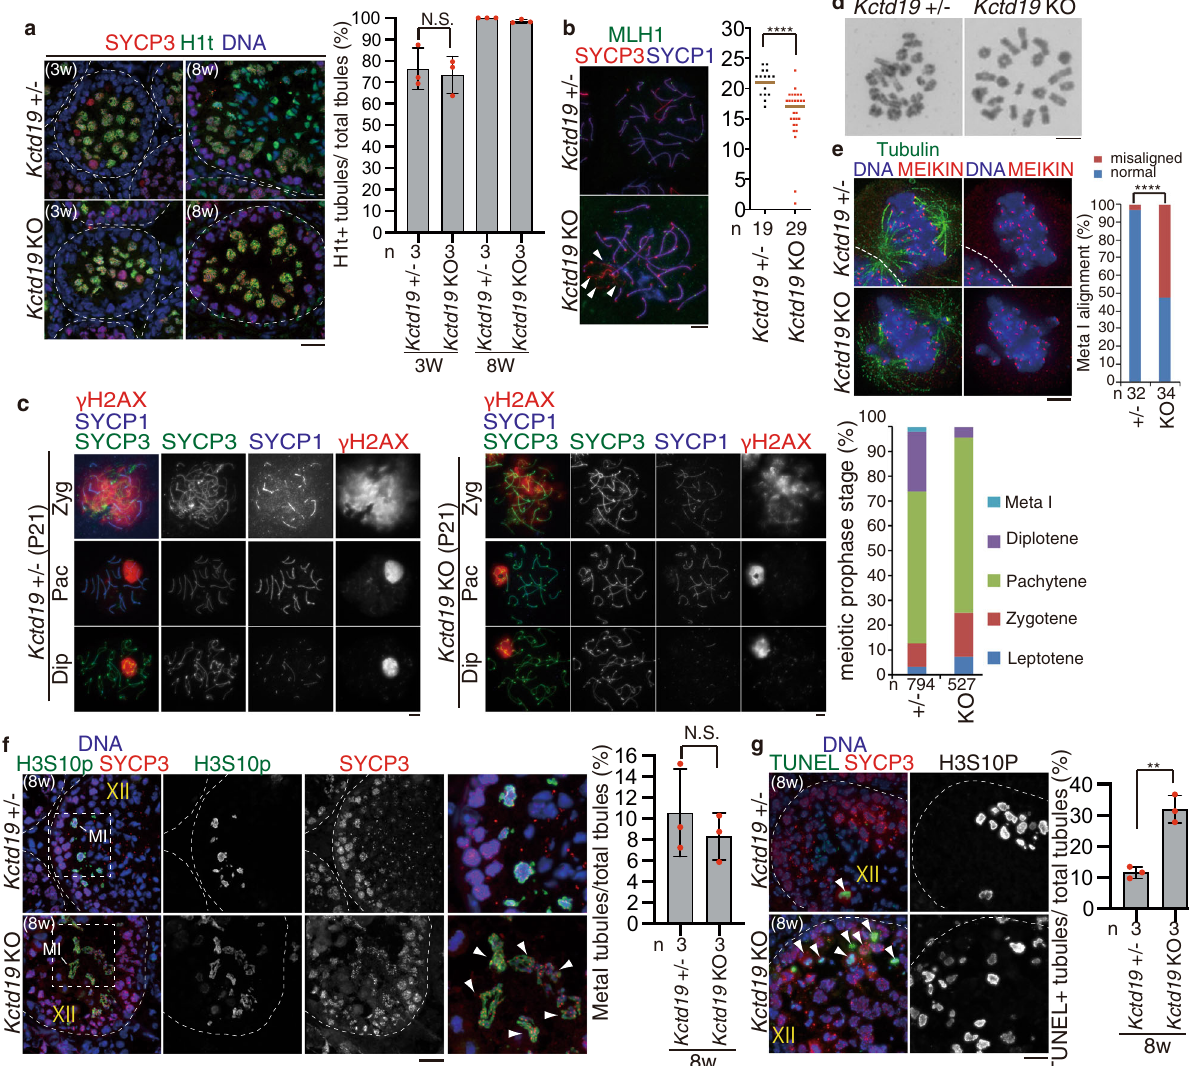
Fig. 6 Kctd19 knockout spermatocytes fail to complete meiosis I. a Seminiferous tubule sections (3-weeks and 8-weeks old) were immunostained as indicated. Shown on the right is the quanti fi cation of the seminiferous tubules that have H1t + /SYCP3 + cells per the seminiferous tubules that have SYCP3 + spermatocyte cells in Kctd19 ± and Kctd19 KO mice (mean with SD). n : the number of animals examined for each genotype. Statistical signi fi cance is shown (two-tailed t -test). N.S.: statistically not signi fi cant. Scale bar: 25 μ m. b Chromosome spreads of Kctd19 ± and Kctd19 KO spermatocytes were immunostained as indicated. The number of MLH1 foci is shown in the scatter plot with median (right). Statistical signi fi cance is shown by p -value (two-tailed Mann – Whitney U -test). **** p < 0.0001. n : number of spermatocytes examined. Asynapsed chromosomes in MLH1 + pachytene spermatocytes are indicated by white arrowheads. Scale bar: 5 μ m. c Chromosome spreads of Kctd19 ± and Kctd19 KO spermatocytes at P21 were immunostained as indicated. Zyg: zygotene, Pac: pachytene, Dip: diplotene. Quanti fi cation of meiotic prophase stage per total SYCP3 + spermatocytes of Kctd19 ± and Kctd19 KO mice is shown on the right. n : the number of cells examined. Scale bar: 5 μ m. d Giemza staining of metaphase I chromosomes from Kctd19 ± and Kctd19 KO spermatocytes. Independent Metaphase I cells (at least N = 19) for each genotype were examined in a single experiment. Scale bar: 5 μ m. e Immunostaining of squashed metaphase I spermatocytes from Kctd19 ± and Kctd19 KO. The metaphase I kinetochores were identi fi ed by MEIKIN immunostaining. Quanti fi cation of metaphase I spermatocytes with chromosome misalignment is shown on the right. n : the number of spermatocytes examined. Statistical signi fi cance is shown by **** p = 2.65 × 10 − 10 (chi-square test). Scale bar: 5 μ m. f Seminiferous tubule sections (8-weeks old) were stained for SYCP3, H3S10p, and DAPI. M I: Metaphase I spermatocyte. Enlarged images are shown on the rightmost panels. Arrowheads indicate misaligned chromosomes. Shown on the right is the quanti fi cation of the seminiferous tubules that have H3S10p + /SYCP3 + Metaphase I cells per the seminiferous tubules that have SYCP3 + spermatocyte cells in Kctd19 ± and Kctd19 KO testes (mean with SD). n : the number of animals examined for each genotype. Statistical signi fi cance is shown by p -value (two-tailed t -test). N.S.: Statistically not signi fi cant. Scale bar: 25 μ m. g Seminiferous tubule sections from 8-weeks old mice were subjected to TUNEL assay with immunostaining for SYCP3 and H3S10p. Arrowheads indicate TUNEL-positive cells. Shown on the right is the quanti fi cation of the seminiferous tubules that have TUNEL + cells per total tubules in Kctd19 ± and Kctd19 KO testes (mean with SD). Statistical signi fi cance is shown by ** p = 0.0019 (two-tailed t - test). Scale bar: 25 μ m. Boundaries of the seminiferous tubules are indicated by white dashed